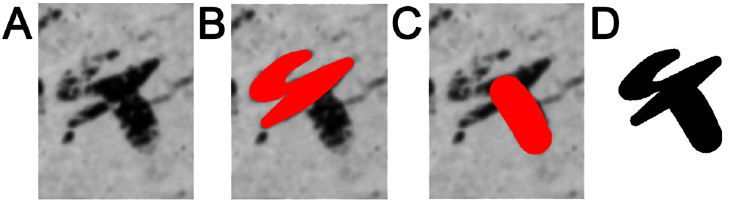
Fig 4. Restoration of a character waw in Arad Ostracon 24. (A) The original image. (B and C) reconstructed strokes. (D) The resulting character restoration. Images are courtesy of the Institute of Archaeology, Tel Aviv University and the Israel Antiquities